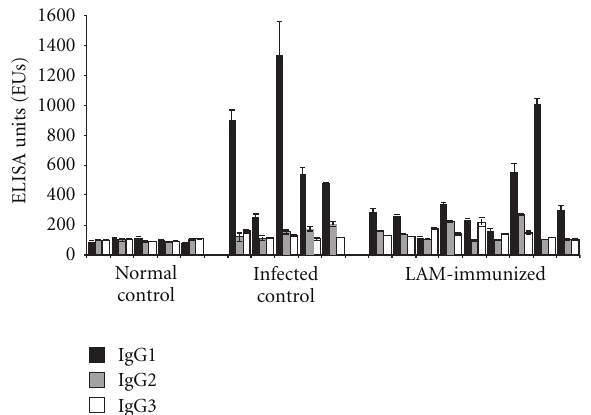
Figure 1: Relative levels of LAM extract-specific IgG isotypes expressed as ELISA Units (EUs) ± standard deviation of two inde- pendent measurements for each animal at 1 :100 dilution of